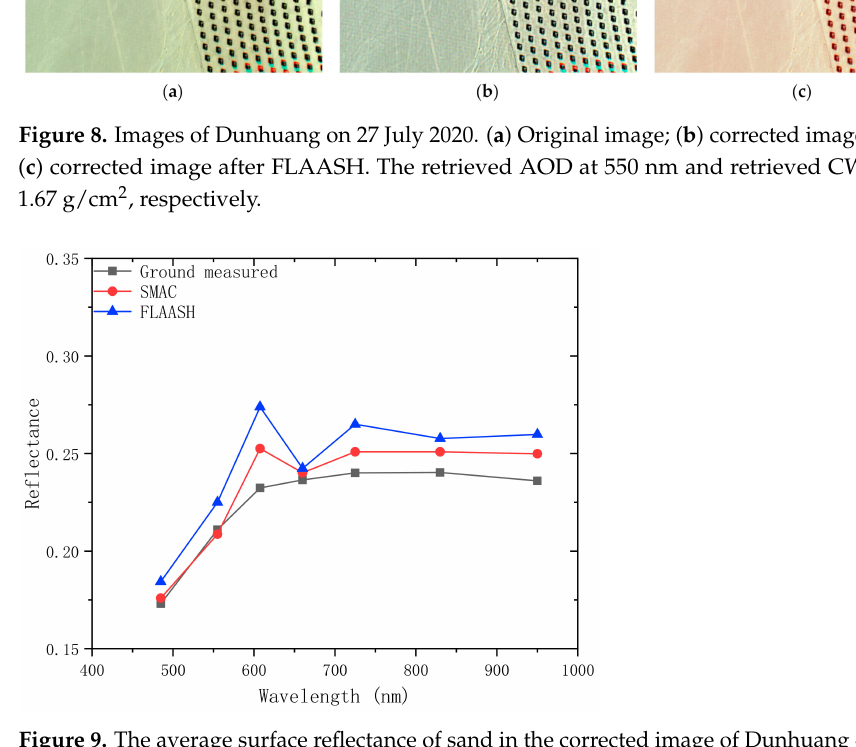
Figure 9. The average surface reflectance of sand in the corrected image of Dunhuang on 27 July 2020 obtained from Syn-AC and FLAASH and the field-measured